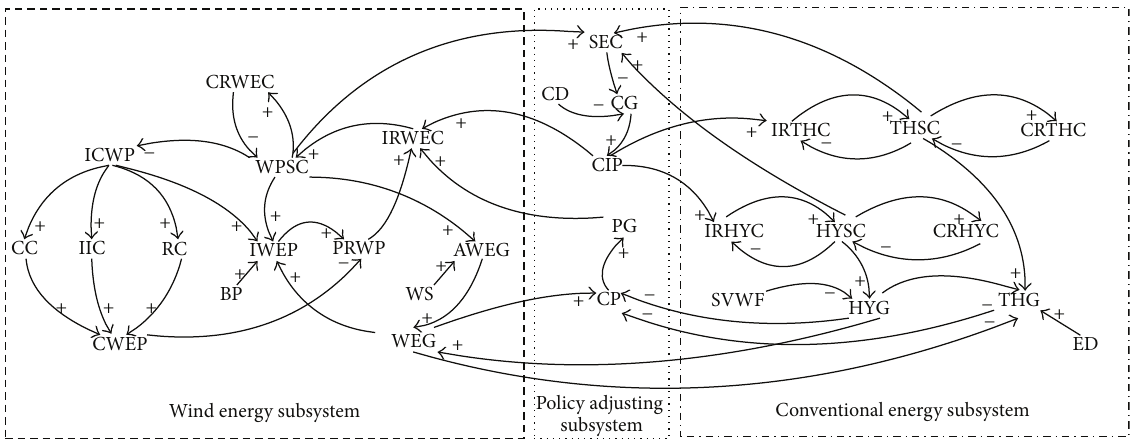
Figure 1: Causal loop